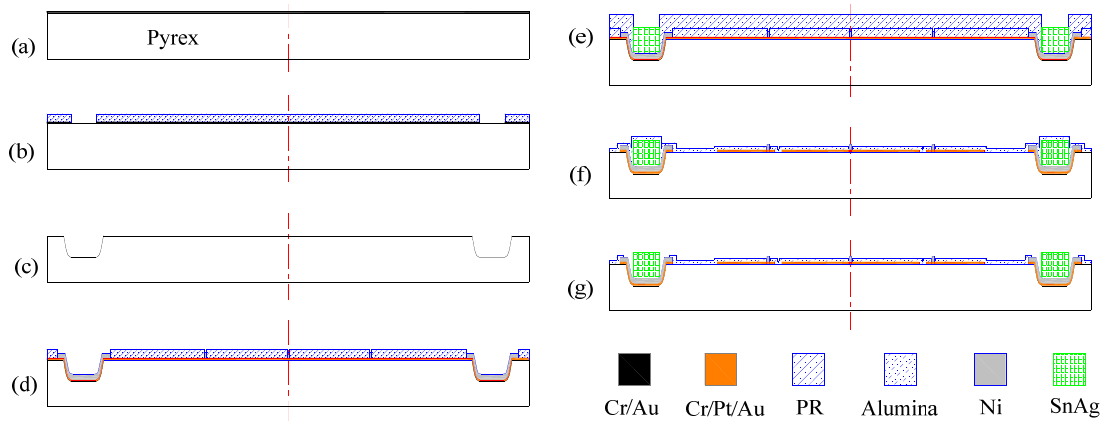
Figure 6. Process flow of the top